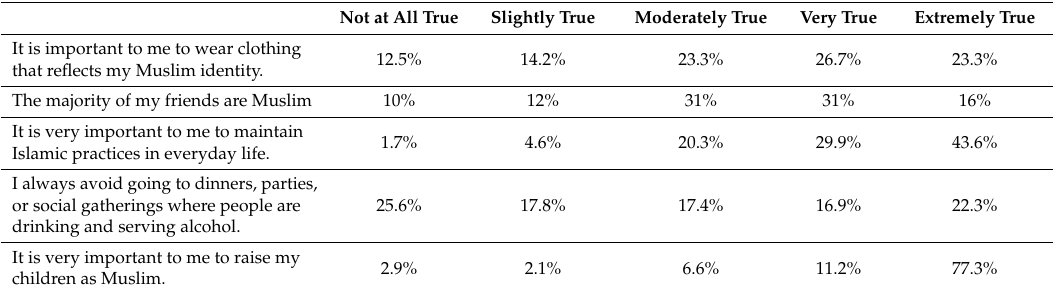
Table 2. Adherence to Islamic Identity